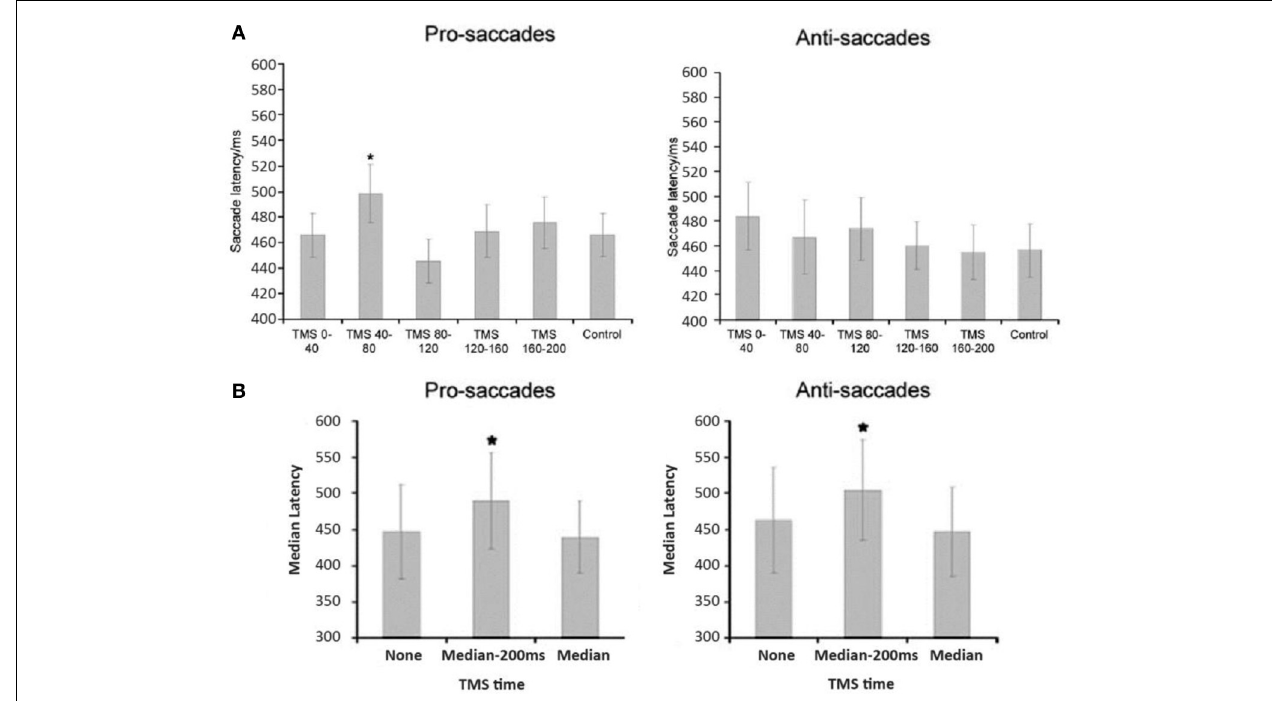
when TMS was delivered starting at 40ms following array onset. Elevated latencies were not significant for antisaccade trials (it is possibly due to containing two populations of responses) in the early TMS time window. For later TMS delivery times (panel B ), both pro- and antisaccade latencies were significantly increased by TMS prior to but not during saccade execution. ∗ denotes statistical comparisons where p < 0 .